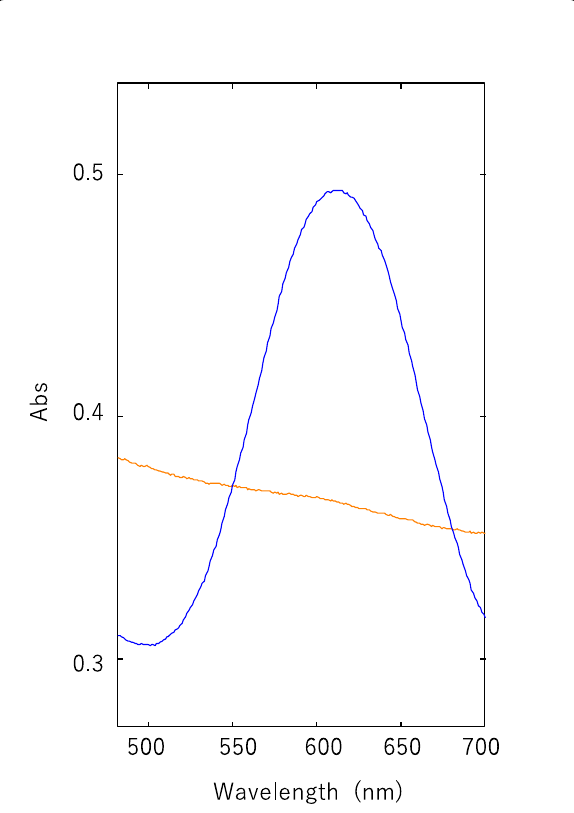
Fig.6 Visible spectra of blue and yellow fraction. Blue line shows spectra of blue fraction, yellow line shows spectra of yellow